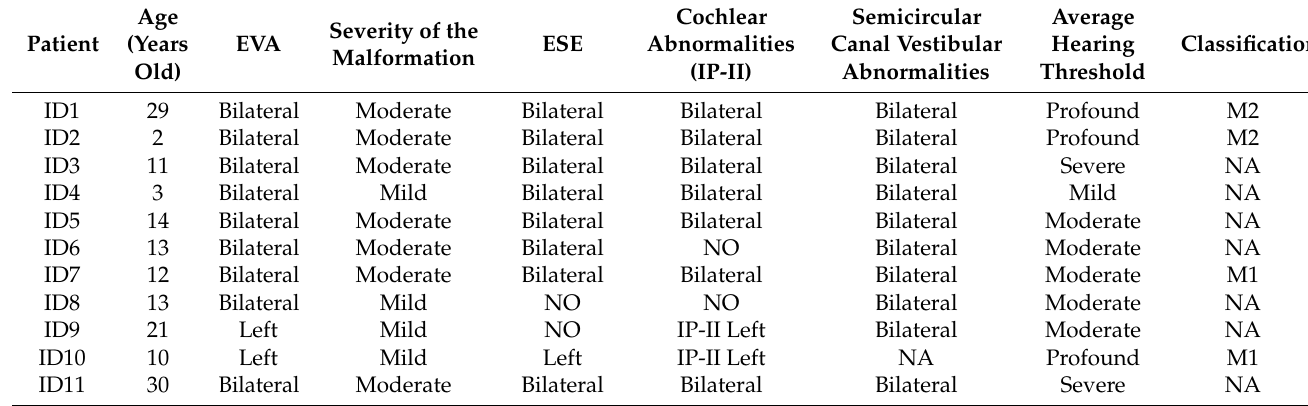
Table 1. Clinical and genetic features of the suspected-PDS